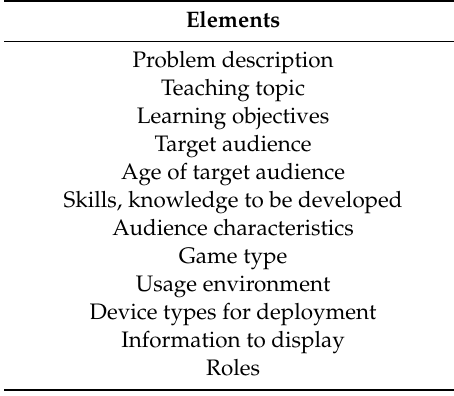
Table 2. Main elements were collected in the interview